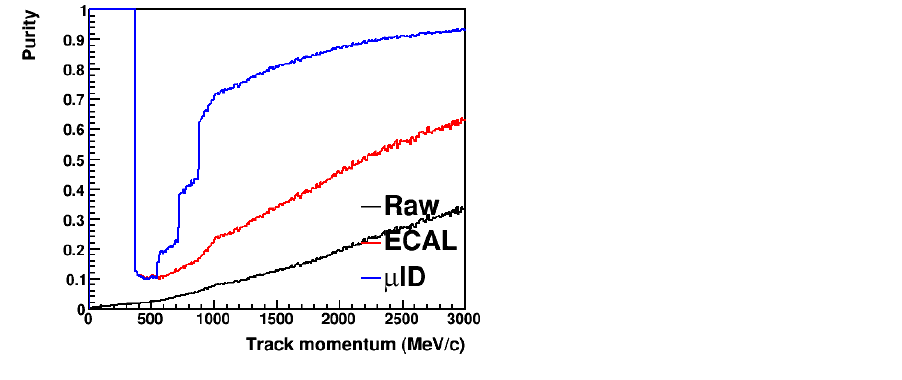
Figure 88. Purity of the wrong sign sample selection of µ + created by ¯ ν µ interaction in FHC. It includes the ranging out selection of muons and pions in the ECAL.